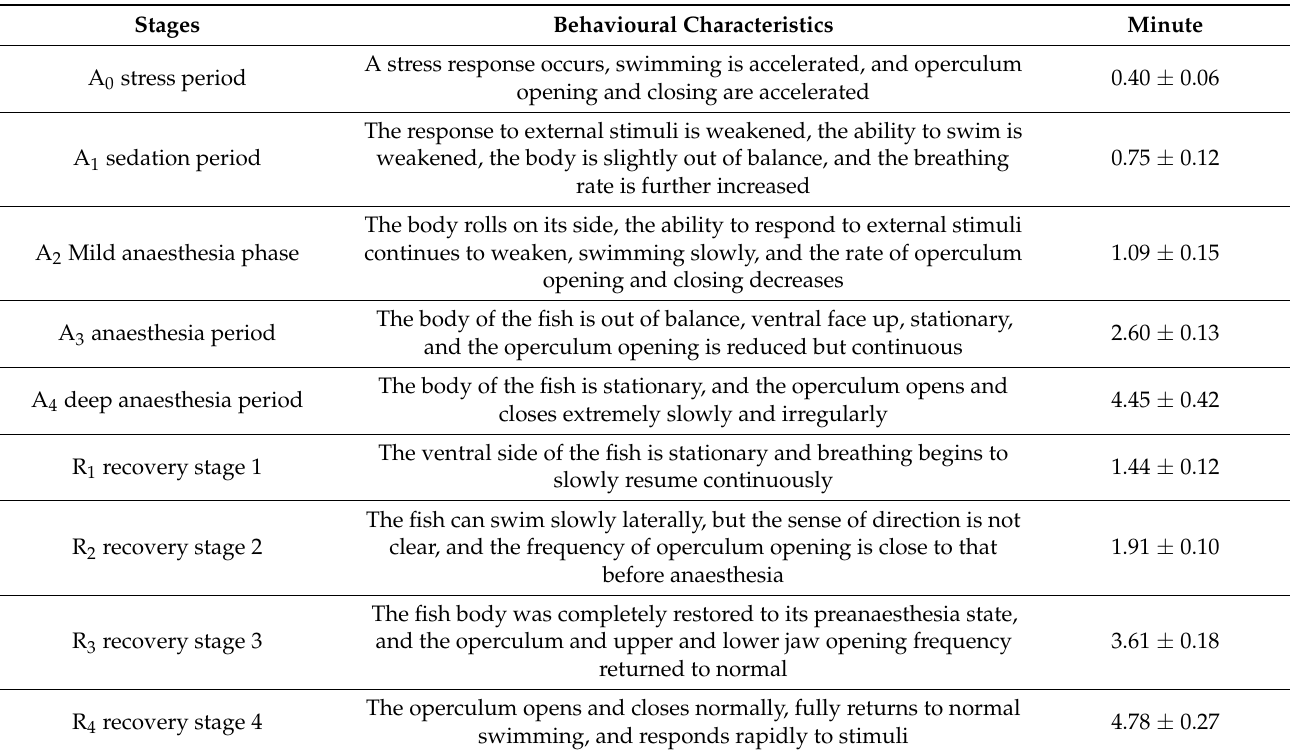
Table 3. Behavioural characteristics of crucian carp during the successive stages of anaesthesia and